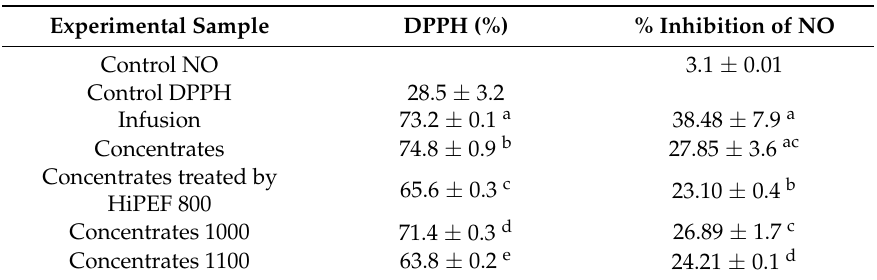
Table 5. Antioxidant